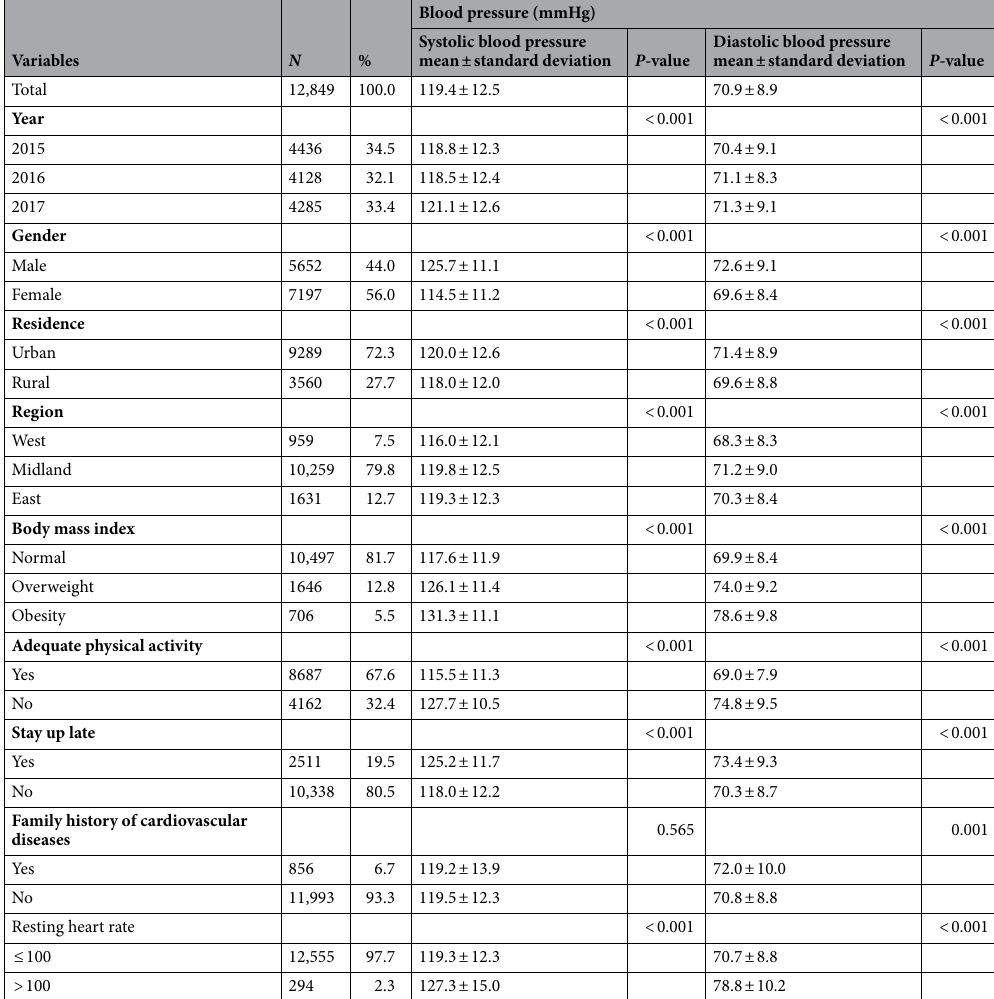
Table 2. Socio-demographic characteristics and blood pressure of the